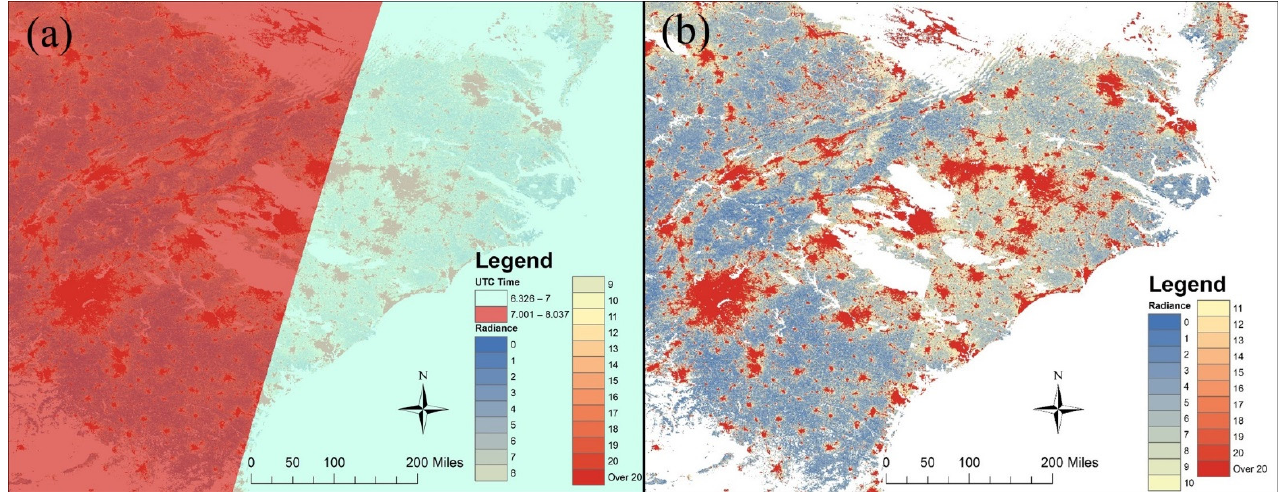
Figure 5. ( a ) NTL on 8 November in Tile h09v04 and h10v04 with the acquisition time as background ( b ) NTL radiance on 8 November in Tile h09v04 and Tile h10v04, which shows a clear cut-off line.